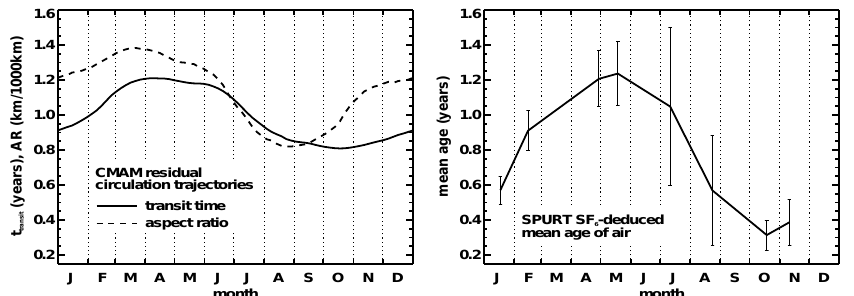
Fig. 9. Same as Fig. 7 but for the tropics. Note annual mean transit times are given in days here. Contours and color shading are limited to less than 100% in the case of the aspect ratio (right). Latitudes and times of exceedingly large aspect ratio mark maximum tropical upwelling there (i.e. corresponding trajectories have an almost vanishing horizontal range).